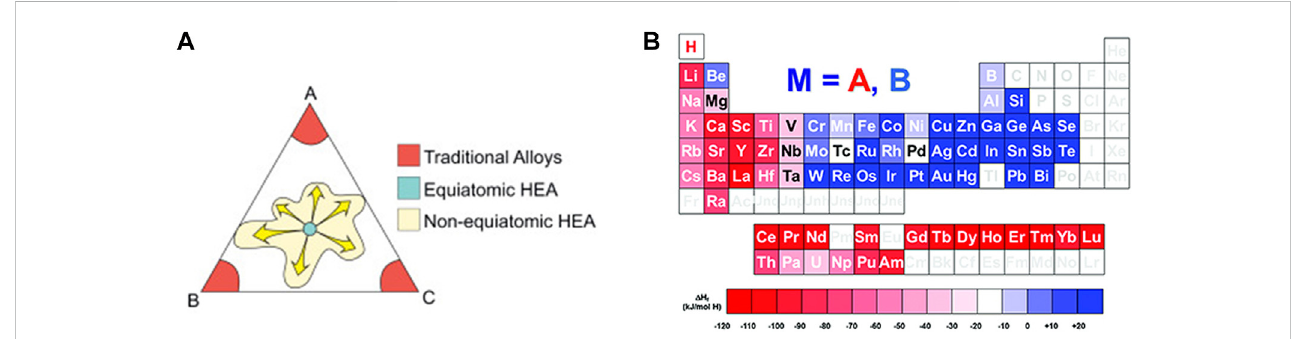
FIGURE 2 Comparison of the positions of high entropy alloys and conventional alloys on the isothermal cross section of the ternary phase diagram (A) (Pradeep etal.,2015);therelativedivisionofhydrogen-absorbing(inred)andnon-hydrogen-absorbing(inblue)elementsintheperiodictableofelementsaccordingto the enthalpy of formation of M-H metal hydrides (B) (Latroche et al.,